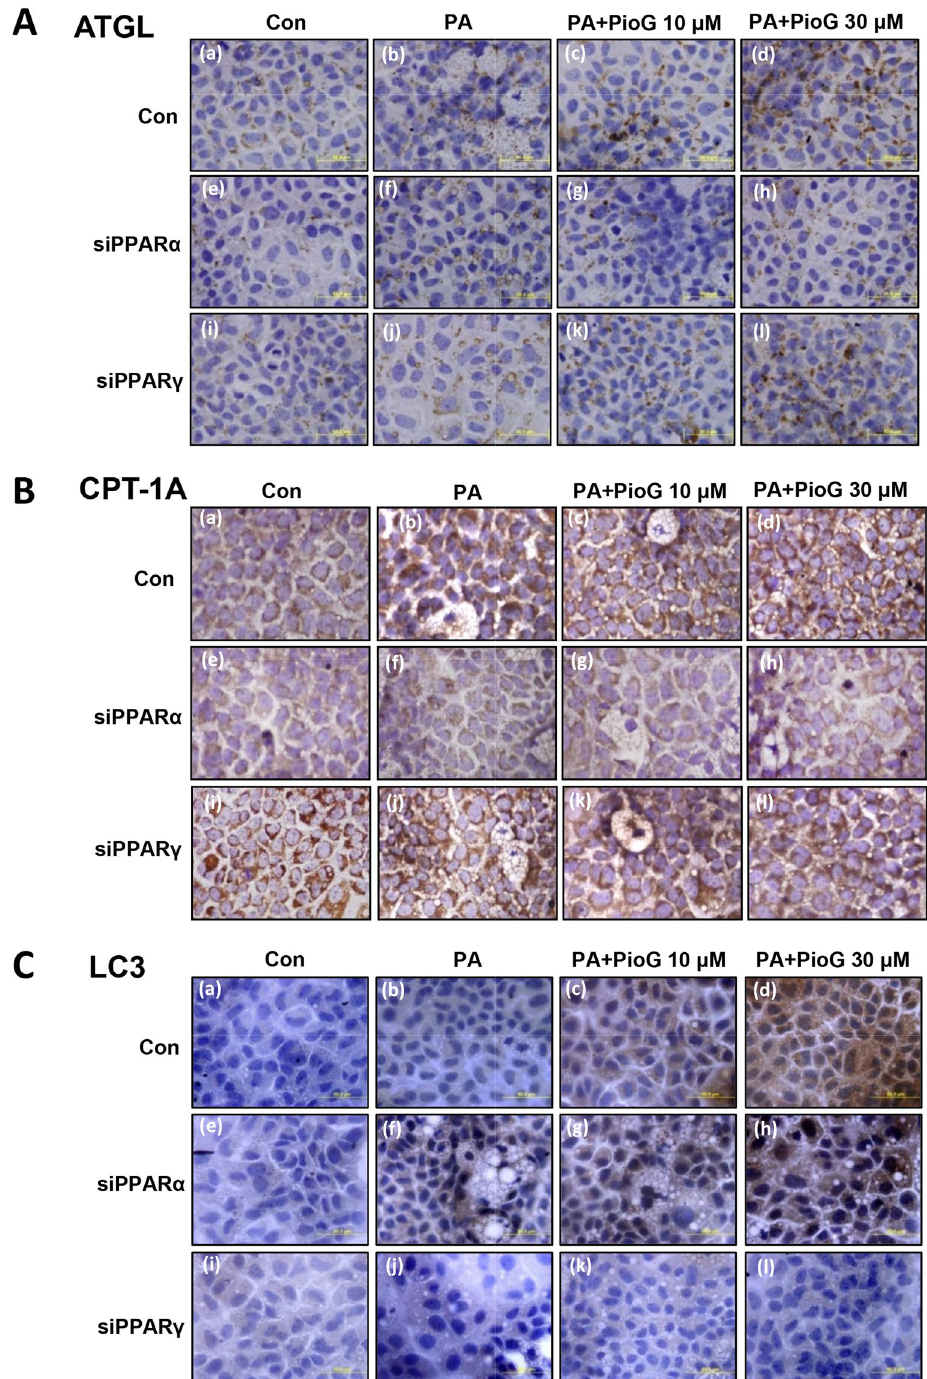
Figure 5. Immunochemical expressions of the ATGL, CPT-1 Α and LC3 were differentially regulated by PPAR α and PPAR γ knockdown. AML12 cells were transfected with siRNA against PPAR α , PPAR γ , and non-targeting control siRNA, respectively. Then, the cells were treated with palmitic acid (PA, 400 μ M) with or without pioglitazone (PioG, 10 or 30 μ M) for 3 days. Protein expressions were analyzed by immunohistochemistry using antibody against ( A ) ATGL, ( B ) CPT-1 Α , and ( C ) LC3,